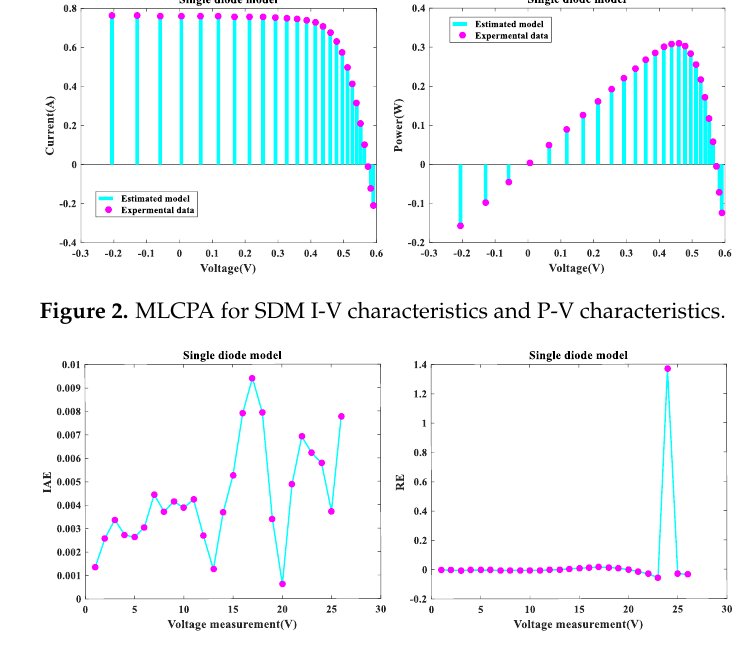
Figure 3. Error index values on SDM IAE values and RE values. Table 5. IAE of MLCPA on